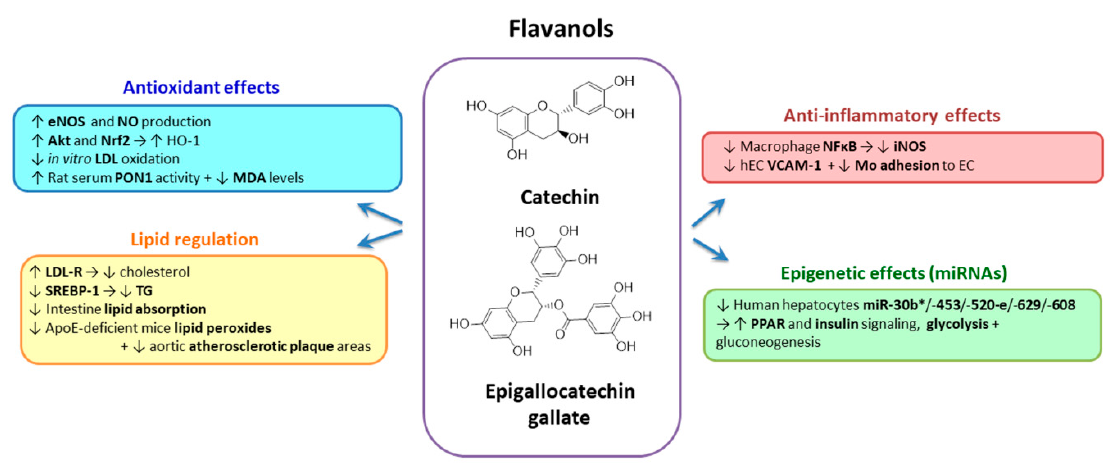
Figure 6. Chemical structures of catechin and epigallocatechin gallate and their molecular mechanisms of action to combat cardiovascular diseases.